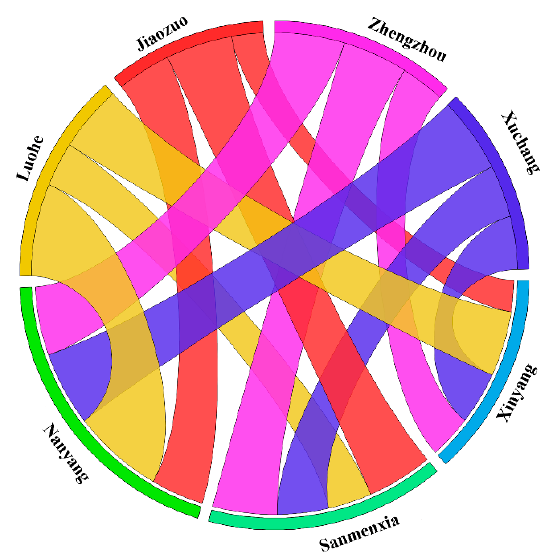
Figure 6. Carbon sequestration flow between ECPAs and ECRAs.